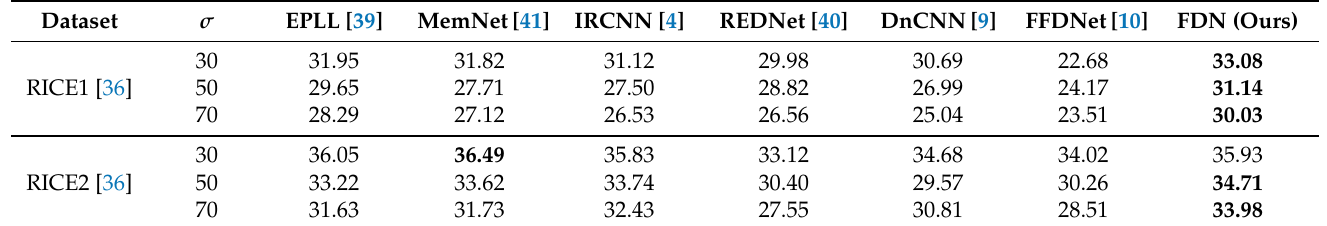
Table 2. Performance comparison on the two remote sensing datasets.